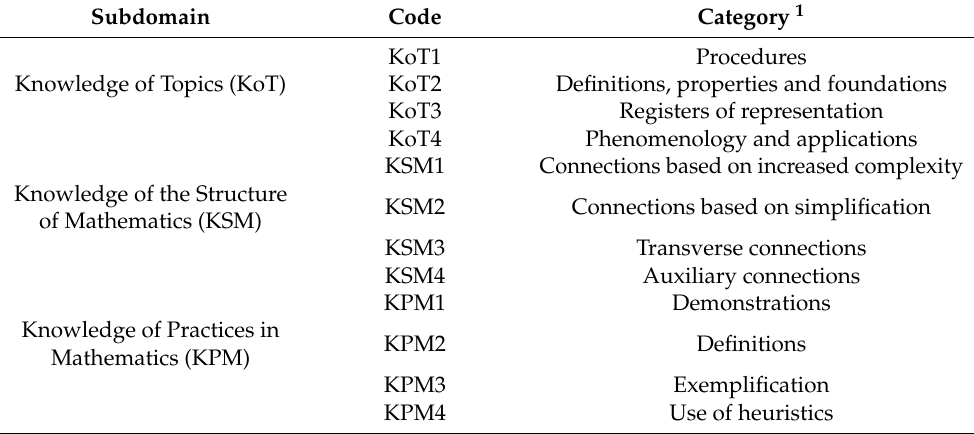
Table 1. Categories of the MK subdomains.